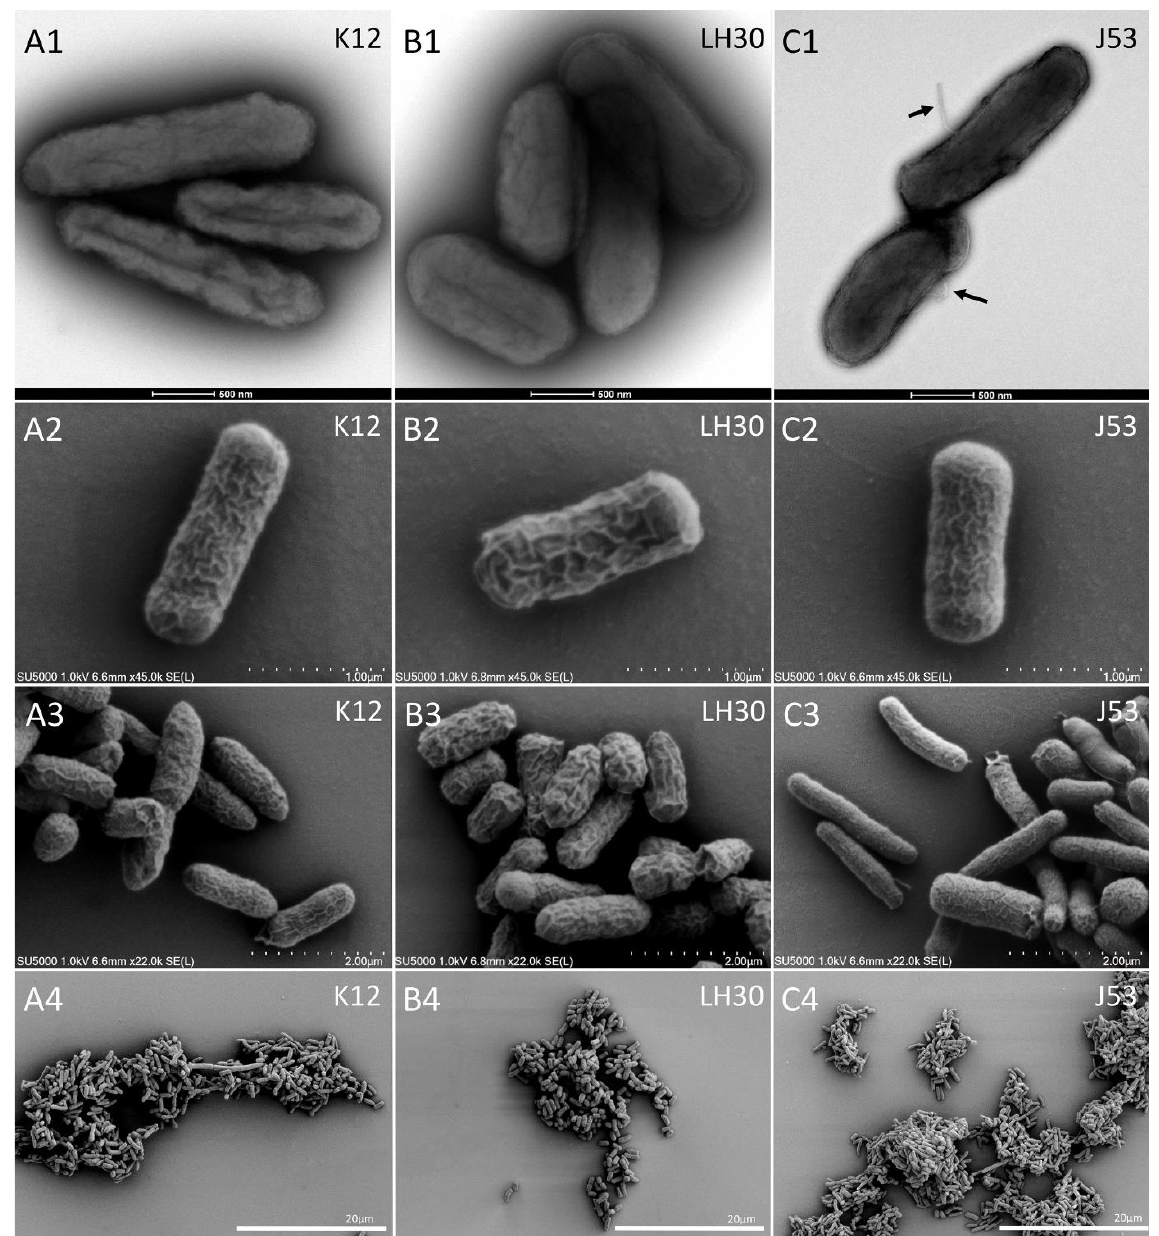
Figure 5. TEM and SE-SEM observation of the whole bacteria strains. ( A1,B1,C1 ): TEM negative staining of K12, LH30 and J53 E. coli bacteria, respectively. Arrows in C1 point to flagella. ( A2 – A4 ): Secondary electrons (SE)-SEM of whole K12 E. coli bacteria. ( B2 – B4 ): SE-SEM of whole LH30 E. coli bacteria. ( C2 – C4 ): SE-SEM of whole J53 E. coli bacteria.